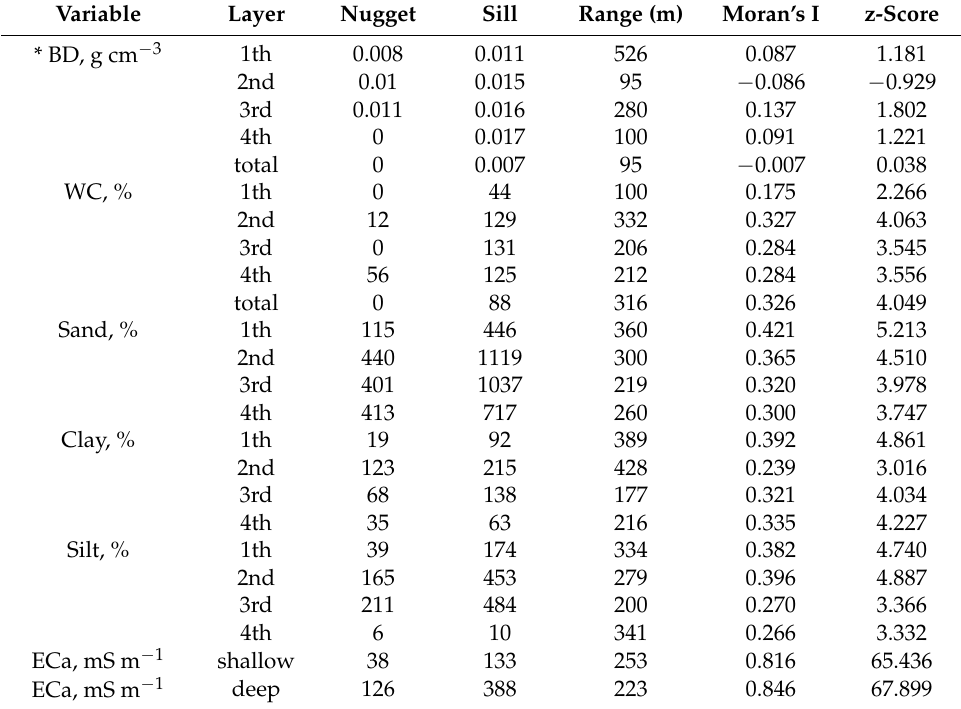
Table 5. Semivariogram and Moran’s I parameters of soil properties for different soil layers. Soil samples were collected at four depths from 0–1 meter at 100